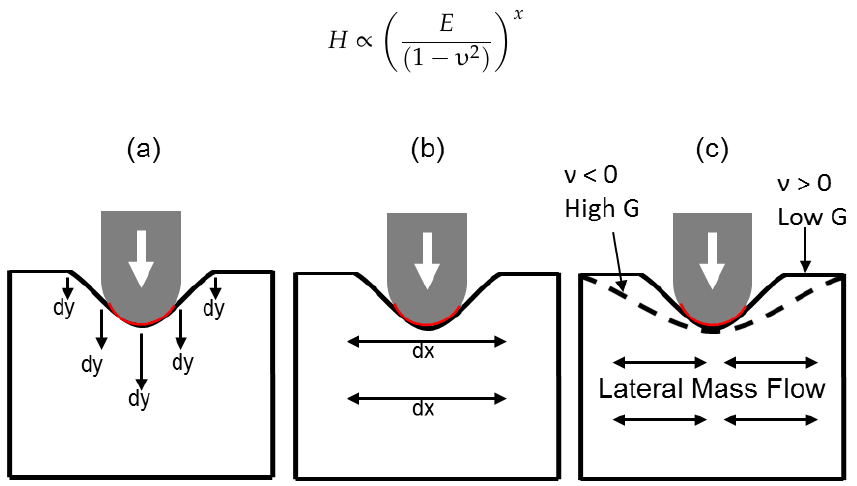
Figure 6. Simplified 2D indentation showing ( a ) Axial deformation; ( b ) Lateral deformation described in Equation (3); ( c ) Effect of large shear modulus (Equation (1)) on indentation area (- - -) and lateral mass flow, both un-accounted for in Equation (3). The red line shows contact area (Equation (4)).